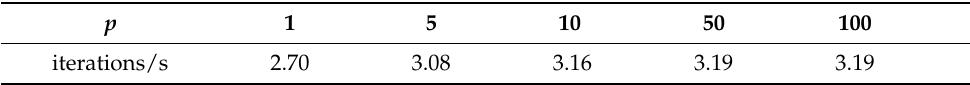
Figure 7. Comparison of FID for different evaluation intervals p on CIFAR-10. Table 2. Training speed for different values of hyperparameter p